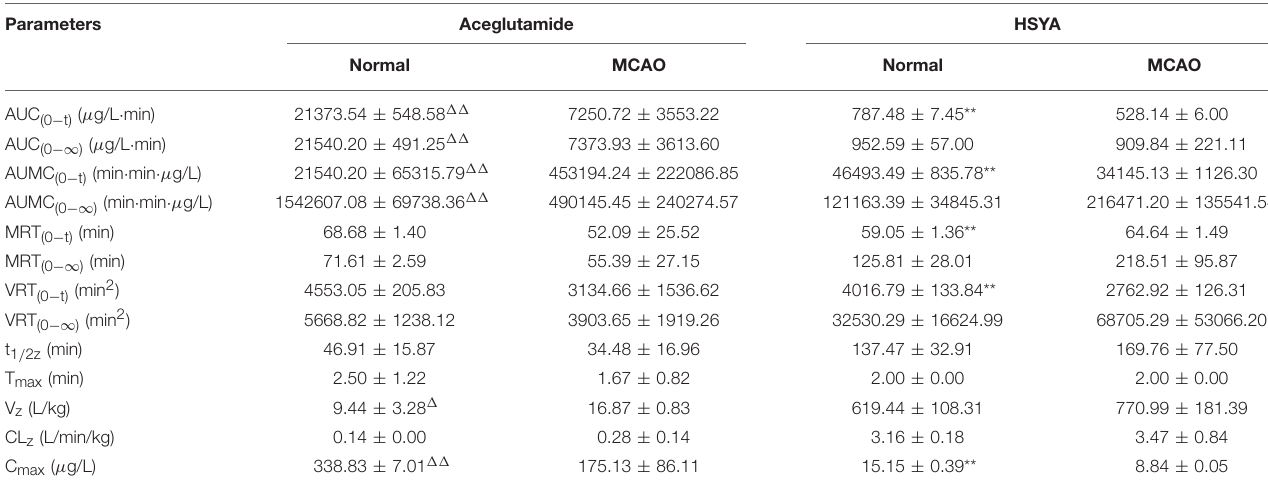
TABLE 2 | Pharmacokinetic parameters of aceglutamide and HSYA in different groups ( x ± s , n = 6).